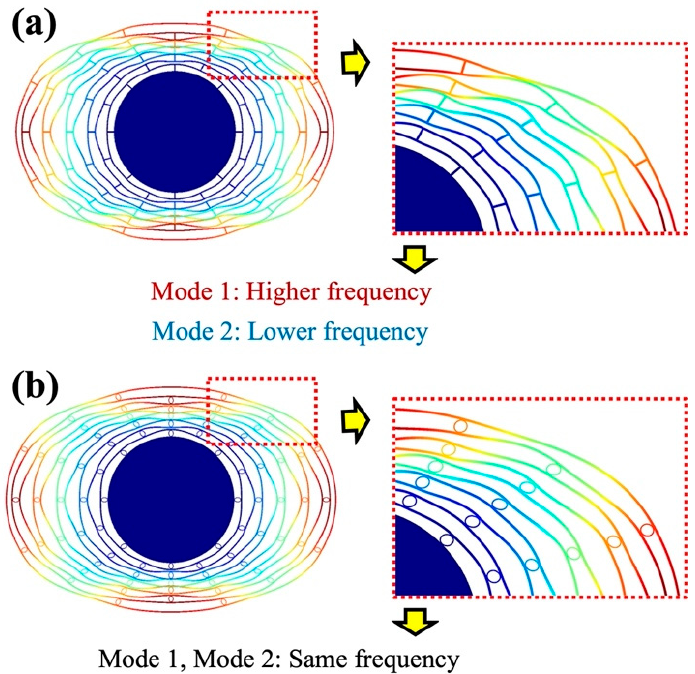
Figure 4. <100> mode shapes deformation in FEM simulation, the distortions of 45° segments are weakened in ( b ) proposed resonator with elliptic spokes, compared with ( a ) conventional resonator with linear beams.